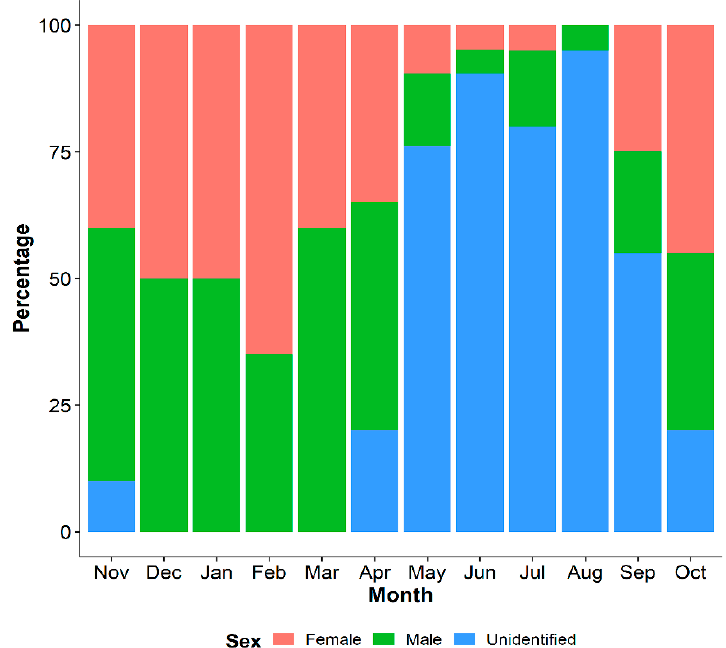
Figure 1. Proportion (%) of male, female, and undifferentiated individuals of Perna viridis collected from the coastal waters of Bangladesh.